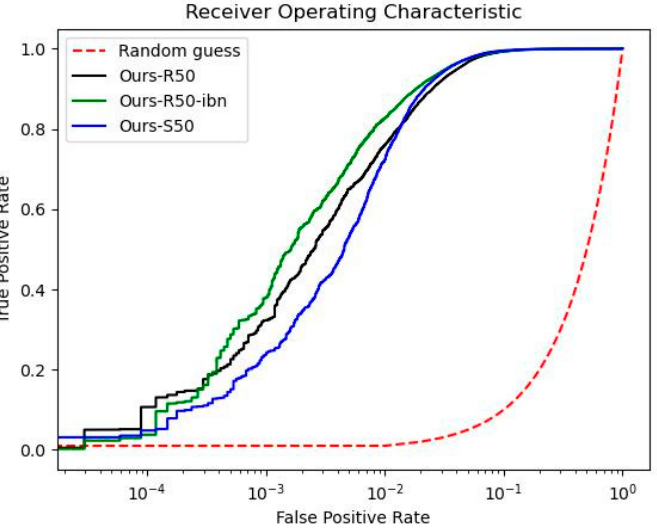
Figure 6. ROC curve with the horizontal axis on a logarithmic scale on DukeMTMC dataset.